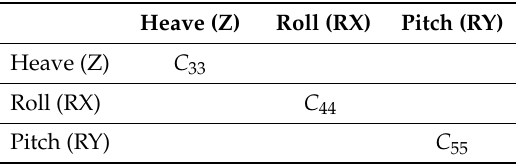
Table 1. Hydrostatic stiffness